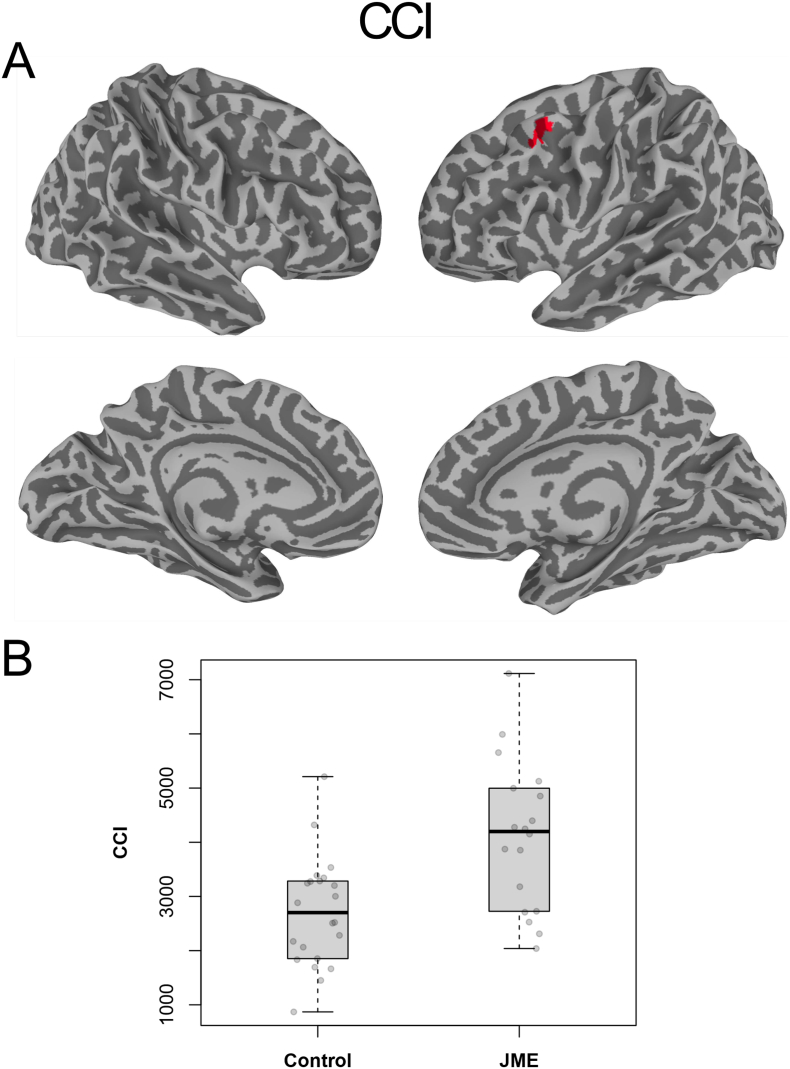
(A) Brain regions with statistical significant difference (Global FPR <5%) in CCI between healthy controls and JME patients; (B) Boxplots of the average CCI values for the individual subjects in the brain regions of interests depicted in (A). Cluster color encoding is arbitrary after ETAC thresholding.